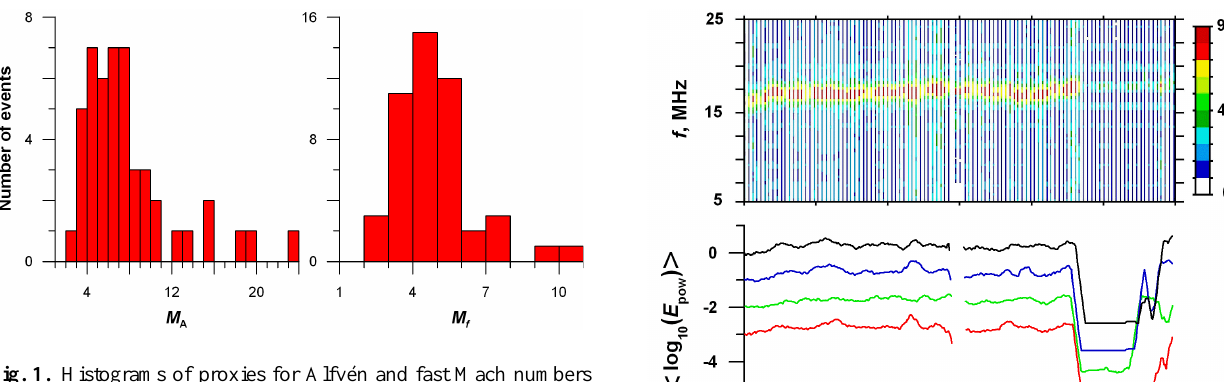
Fig. 1. Histograms of proxies for Alfv´en and fast Mach numbers characterizing quasiperpendicular shocks related to the selected crossings of the foreshock boundary.